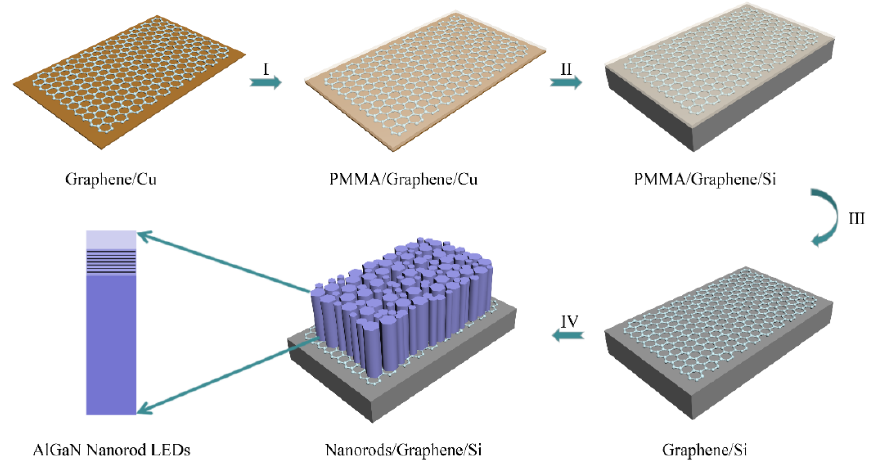
Figure 1. Schematic diagram of the key processes involved in the graphene transfer procedure and the metal organic chemical vapor deposition (MOCVD) growth of AlGaN nanorod LEDs: ( I ) Spin-coated poly(methyl methacrylate) (PMMA) onto graphene on Cu foil; ( II ) transfer of graphene with PMMA onto Si substrate; ( III ) dissolving PMMA; and ( IV ) MOCVD growth of AlGaN nanorod light emitting diodes (LEDs).